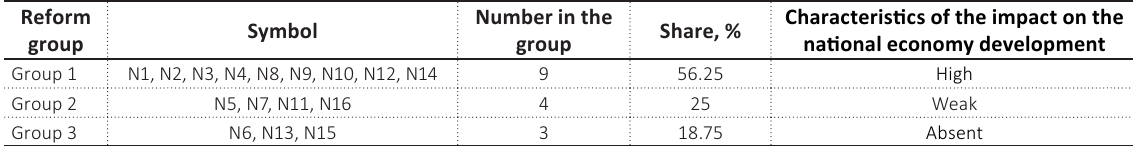
Table 3. Gradation of the effectiveness of reforms and programs for sustainable development of the national economy of Ukraine for 2015–2019 Reform Number in the Share, % Characteristics of the impact on the group national economy